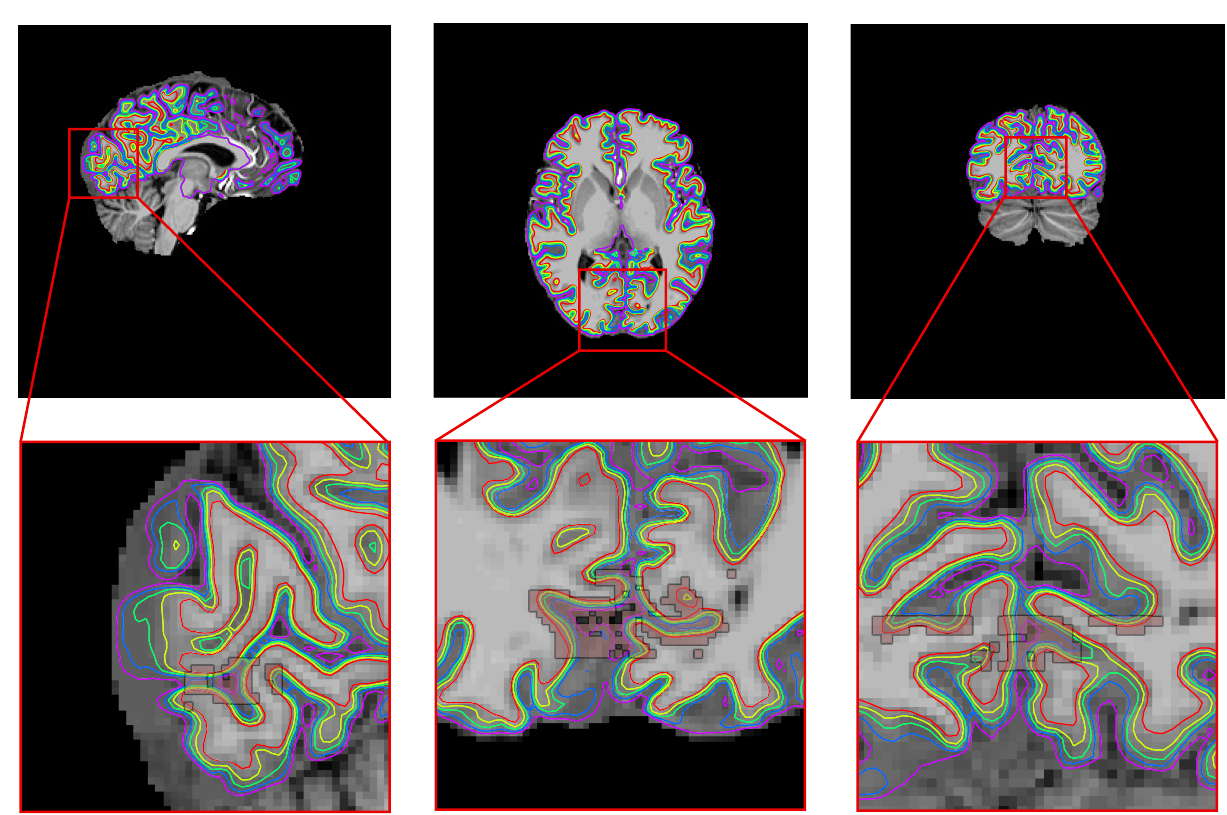
Fig 4. The layering (rainbow colours) and the region of interest (pink) for a representative subject. A small portion of an anatomically defined V1 region was taken in order to investigate the cortical profile in the